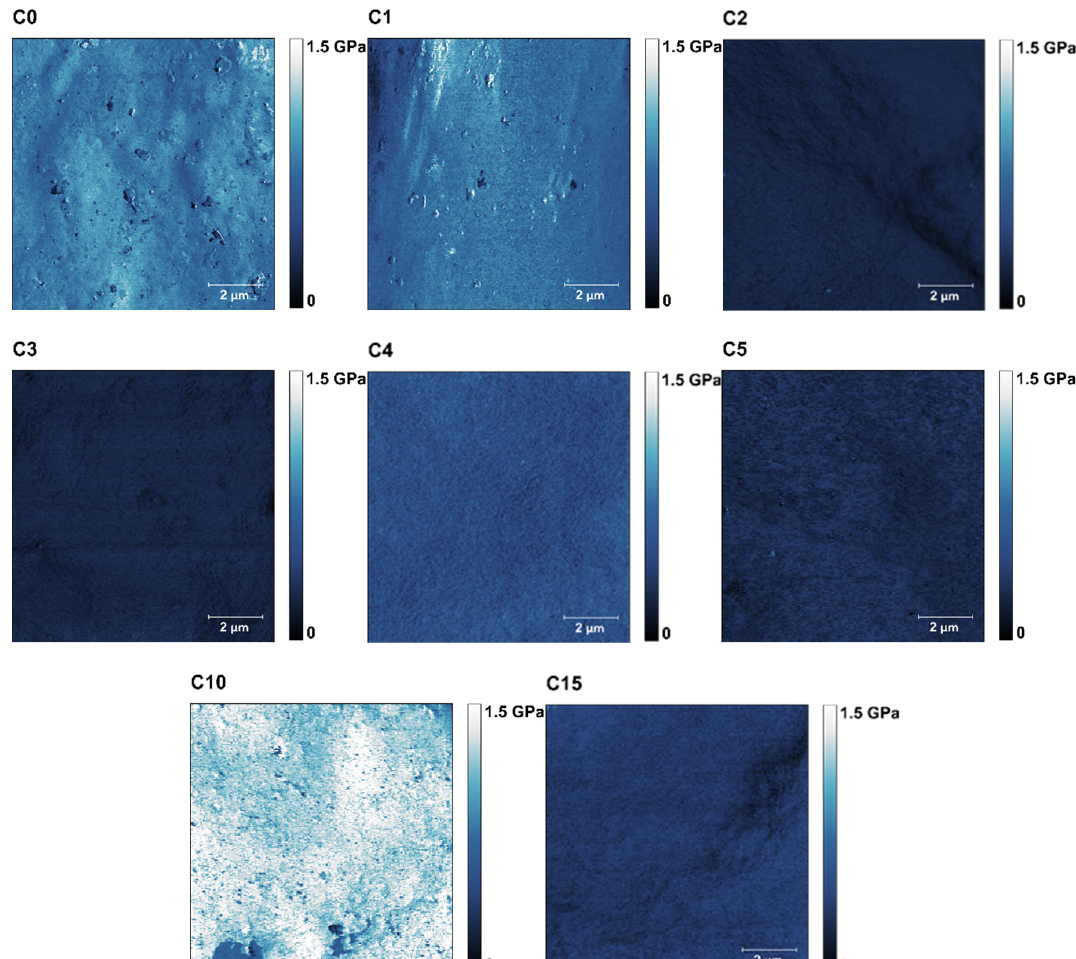
Figure 4. Representative maps of the DMT moduli forces (10 × 10 µ m) for the samples C0–C5, C10, and